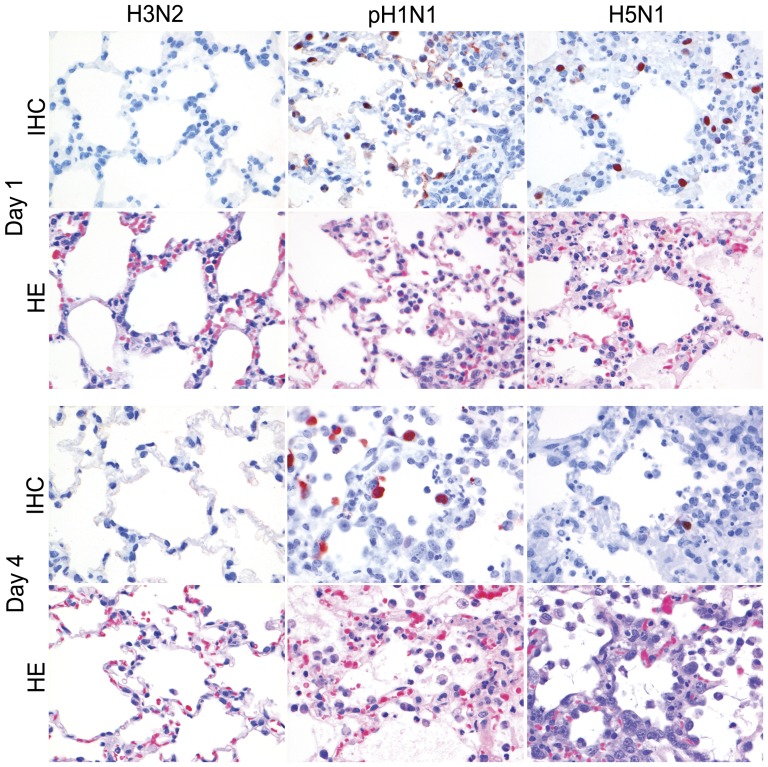
Antigen expression and histopathology of alveolar epithelium of ferrets inoculated with different influenza viruses.There was moderate to high antigen expression for pH1N1 and H5N1 on 1 and 4 dpi with associated lesions characterized by severe DAD and no expression and lesions for H3N2. HE and immunoperoxidase counterstained with hematoxylin, 400×.